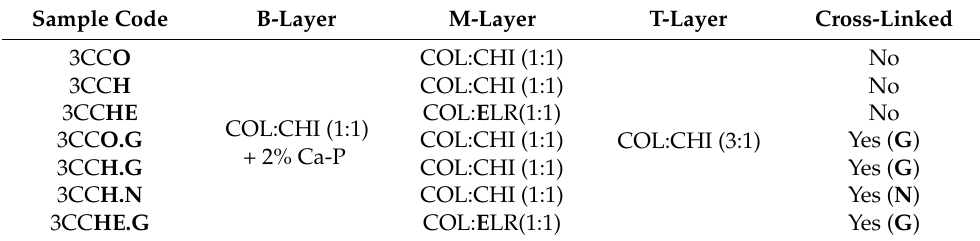
Table 1. Sample codes and compositions of the scaffolds. 3CC means 3 layers with collagen and chitosan. B, M, and T layers mean bottom, medium, and top layers, and bold letters define the specific composition in each scaffold. O—OCP, H—HAP, E—ELR, G—glutaraldehyde;